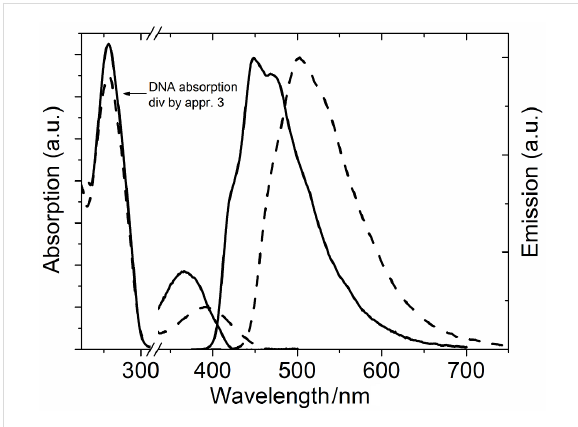
Figure 3: Absorption and emission of tC (dashed line) and tC O (solid line) in dsDNA. The absorption below 300 nm is divided by three to emphasize the absorption spectral features of the lowest energy absorption bands of tC and tC O